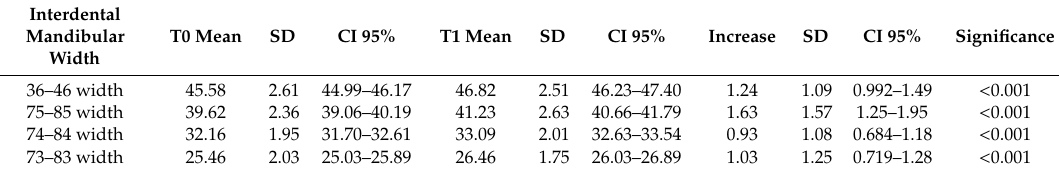
Table 3. Paired t -test comparing the mean interdental mandibular width (mm) increase after SME Treatment—Test Group (n ◦ 69).